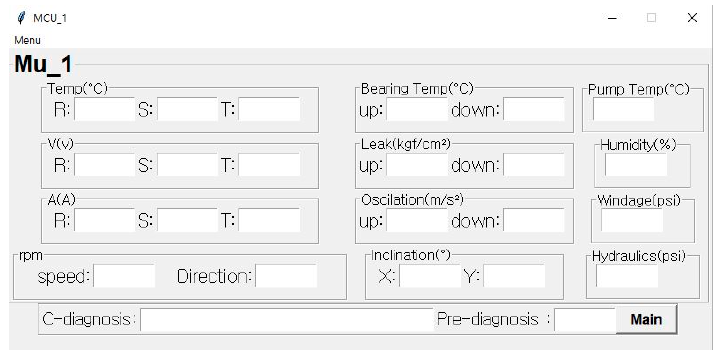
Figure 4. Monitoring system configuration screen of embedded system.